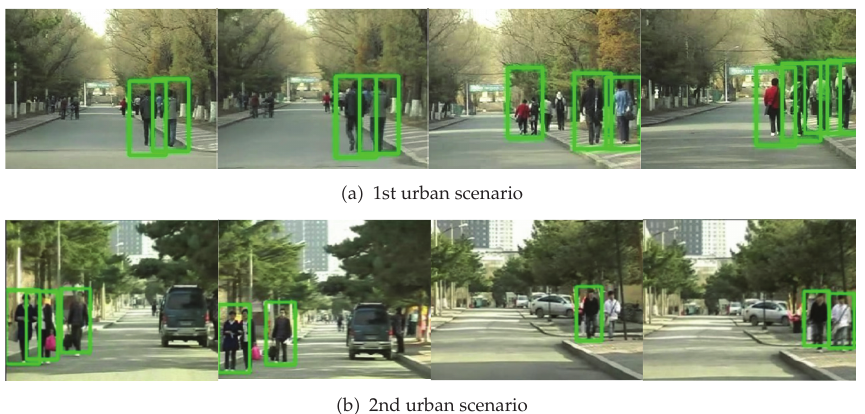
Figure 11: Pedestrian detection with ROI-IHOG (cid:10) SVM.